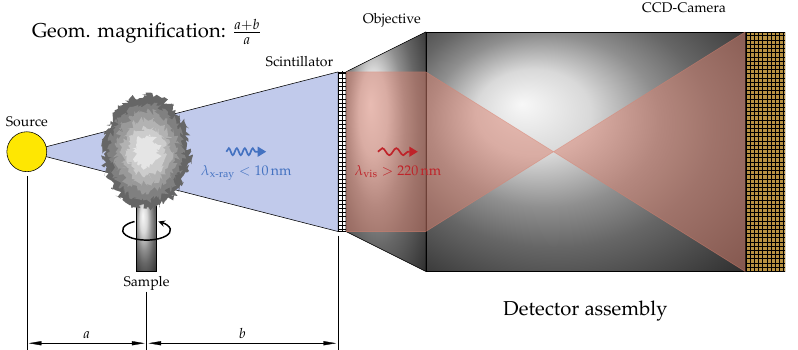
Figure 3. Schematic depiction of the working principle of Micro Computer-Tomography. The source emits a X-ray spectrum that gets scattered by the sample due to photo- electric effect and Compton scattering. This causes signal attenuation, registered by the detector. The distances between source, sample and detector are adjustable, resulting in geometric magnification. At the detector front is a scintillator membrane which converts X-rays to visible light. This enables an additional optical magnification with a conventional objective and the use of a CCD camera as detector. During one CT scan the sample rotates 360°. Various transmission images, so-called projections, are taken at different sample angles and afterwards reconstructed to a three-dimensional